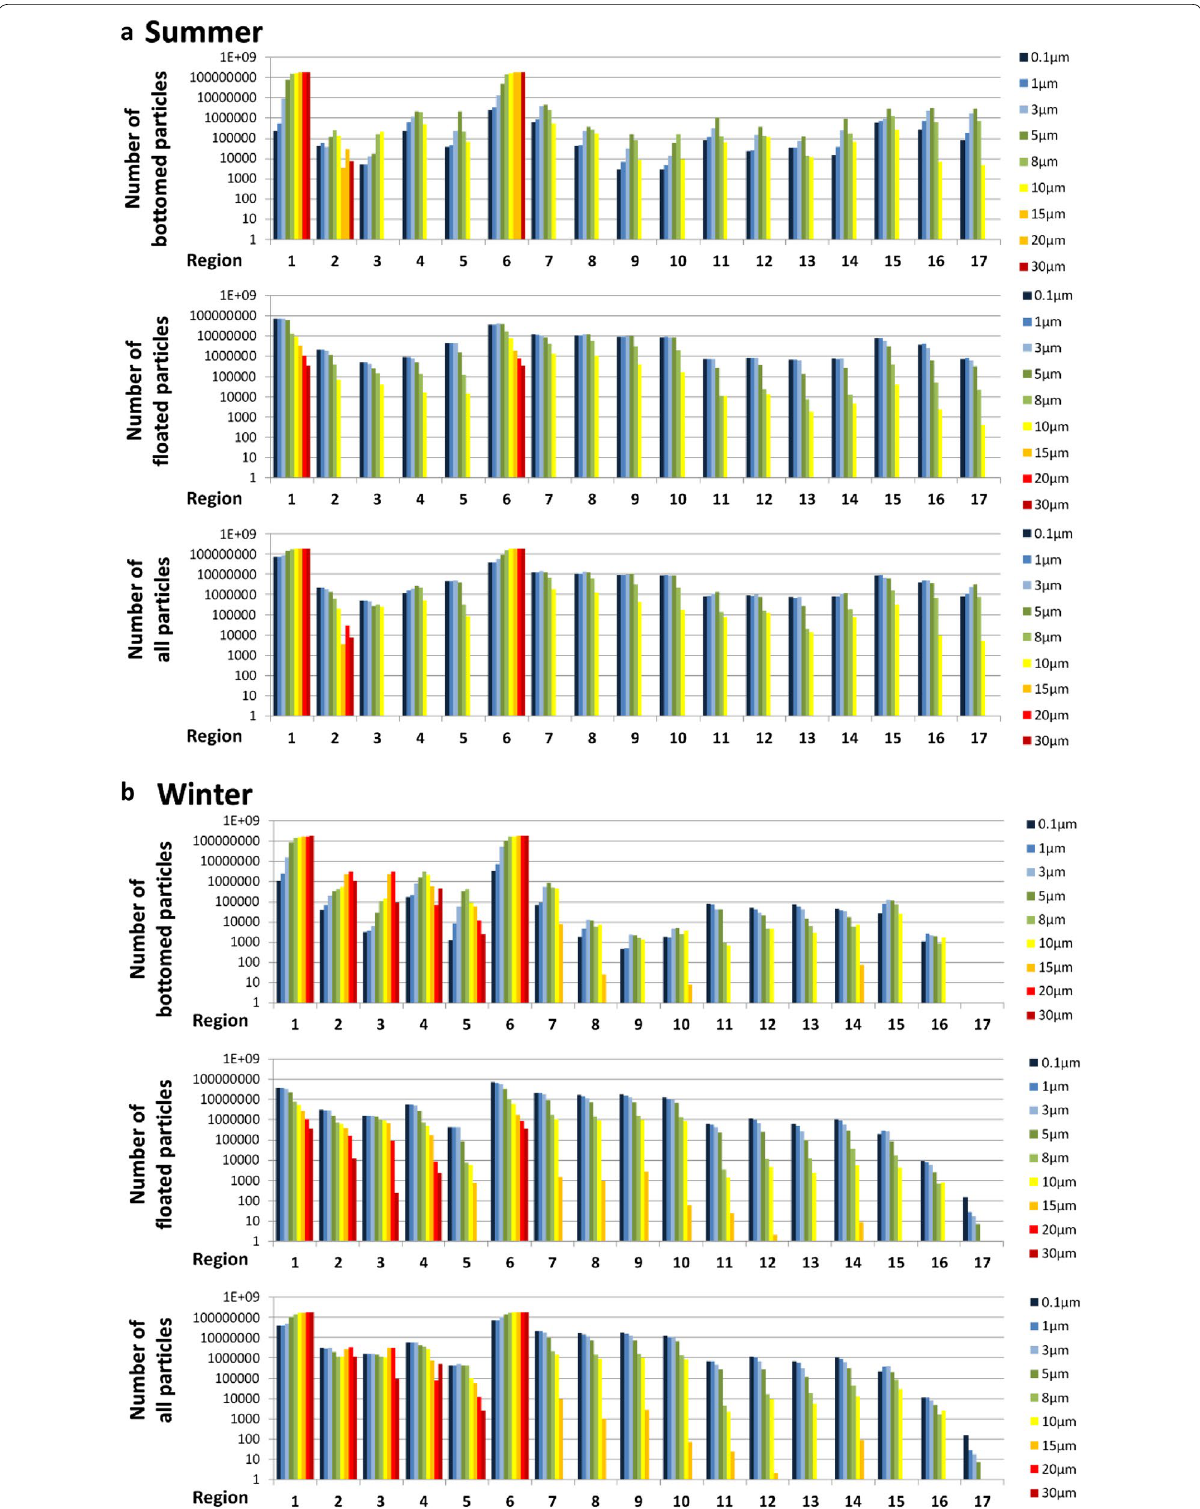
Fig. 4 Numbers of soil particles by region, particle diameter, and particles states (bottomed and floated) integrated in a summer and b